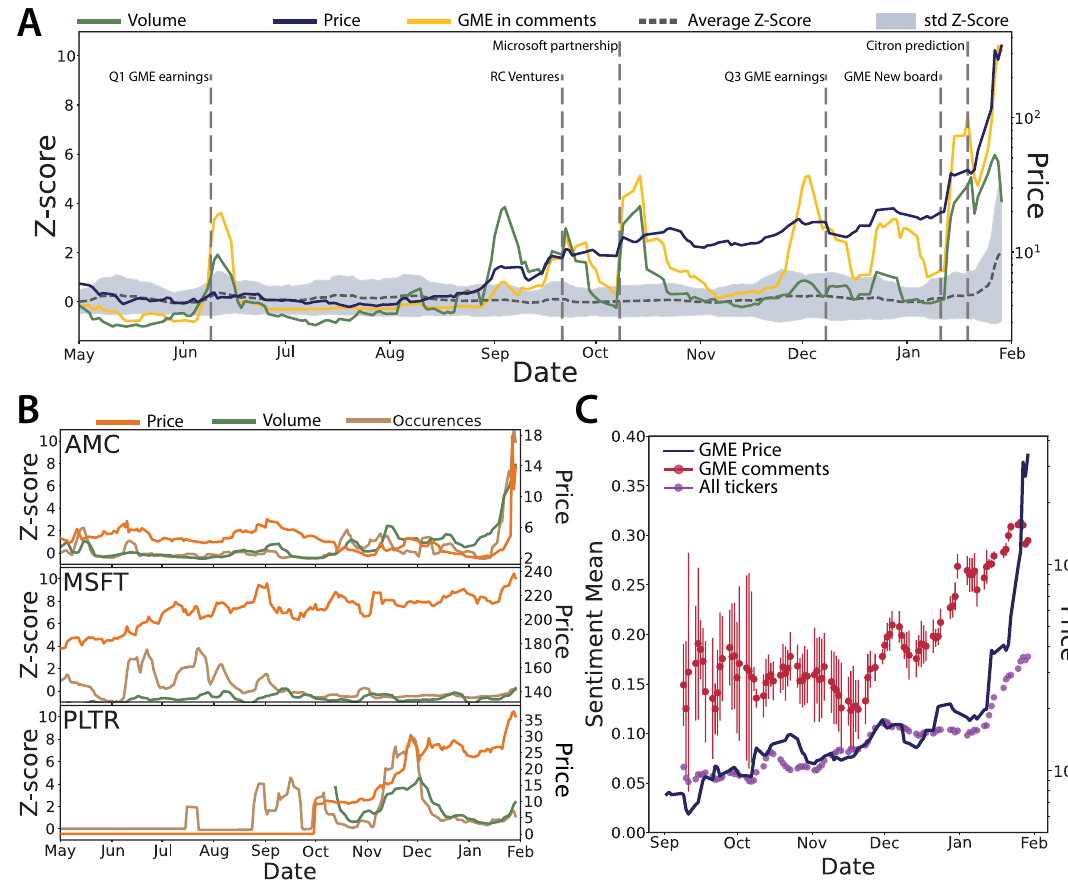
Figure 2. Content and sentiment of WSB conversations across the GME saga. In the following plots we do not consider daily data for weekends and US holidays, when activity on WSB is lower as the stock exchange is closed. We also apply a 5-day moving average to the time series. ( A ) Z-score for the occurrences of ‘GME’ in WSB conversations, compared to the mean Z-score for the occurrence of all stock tickers (shaded area). GME peaks correspond to major events in the GameStop saga. We contextualize these events by also reporting the Z-score of GME trading volumes and the closing price of GME shares. ( B ) For other three representative stocks (AMC, MSFT, PLTR): Z-score of the ticker occurrences in conversations, Z-score of trading volumes and closing price. ( C ) Mean sentiment (and standard deviation of the mean) of comments containing ‘GME’, with respect to the same quantity computed on all comments. GME closing price is also reported for illustrative